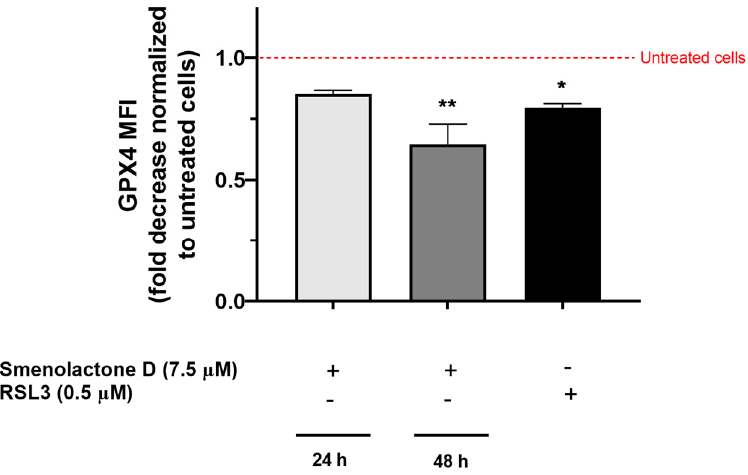
Figure 8. Smenolactone D induces a time-dependent decrease in GPX4 protein expression. GPX4 protein expression is indicated as MFI fold decrease compared to untreated cells. Jurkat cells were treated with smenolactone D (7.5 µ M) for 24 or 48 h, or with RSL3 (0.5 µ M) used as positive control for 24 h. * p < 0.05; ** p < 0.01 compared to untreated cells.